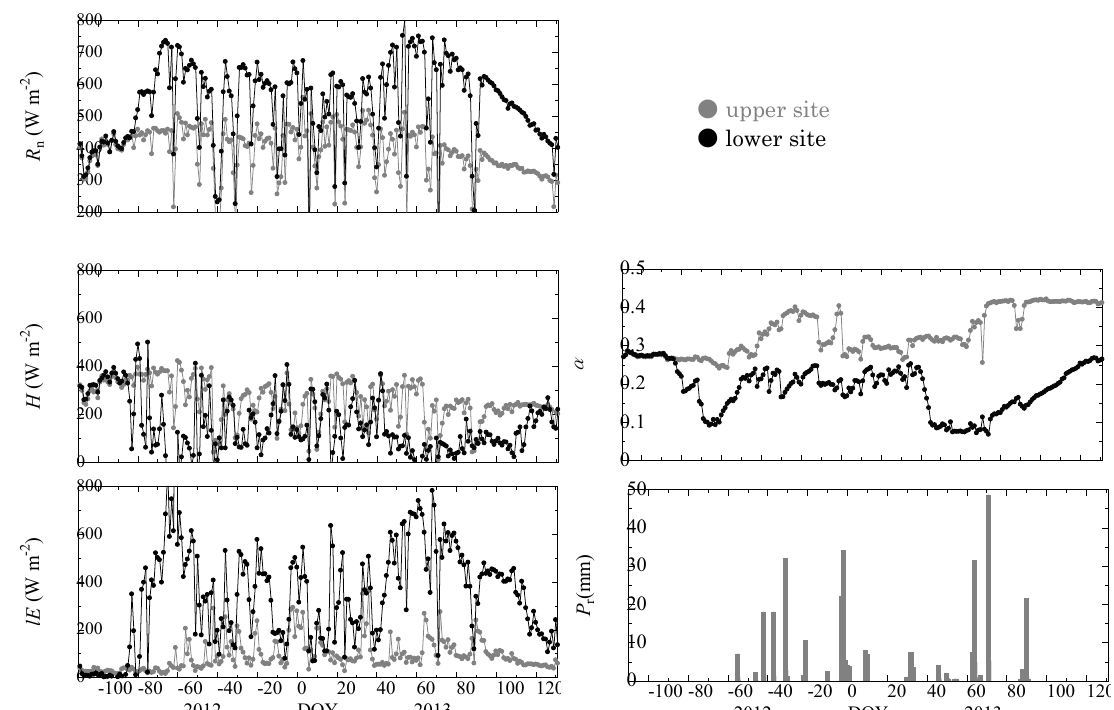
Fig. 3 Same as Fig. 2 but for net radiation ( Rn ), sensible heat flux ( H ), latent heat flux ( lE ), surface albedo ( α ), and precipitation ( Pr